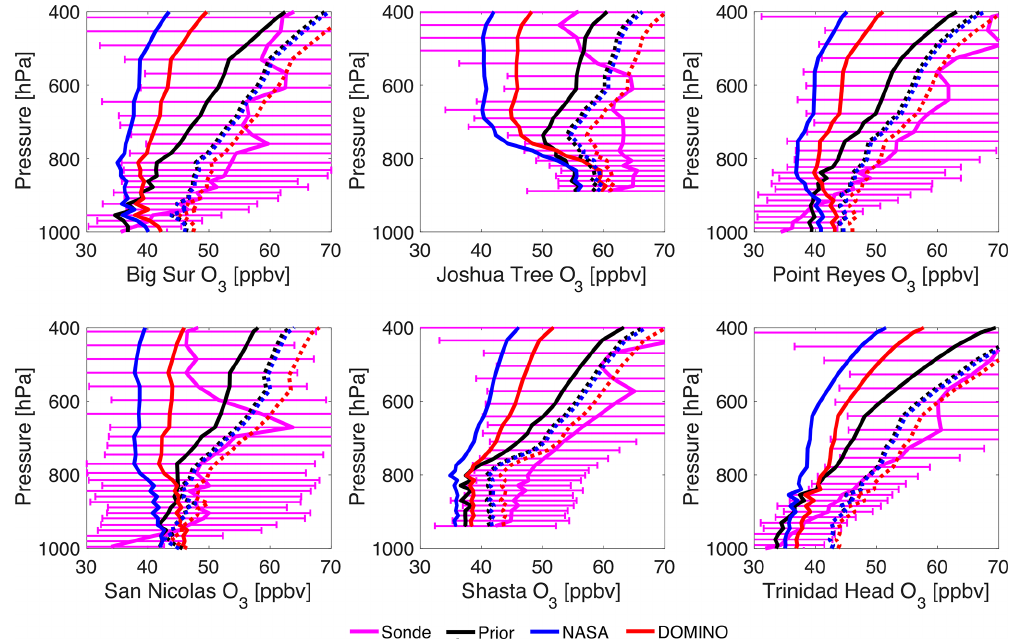
Figure 10. Ozone vertical profiles averaged over May and June 2010 from six ozonesonde measurement sites from the IONS-2010 field experiment in California. The six sites are over remote regions and are used to evaluate the intercontinental transport of ozone. Solid black (prior emissions), blue (NASA posterior emissions), and red (DOMINO posterior emissions) lines are from the GCv12 simulations (prior anthropogenic emissions from CEDS), whereas dashed lines are from the GC-adj simulations (prior anthropogenic emissions from HTAP). The horizontal bars show the standard deviations of the measurements at each vertical